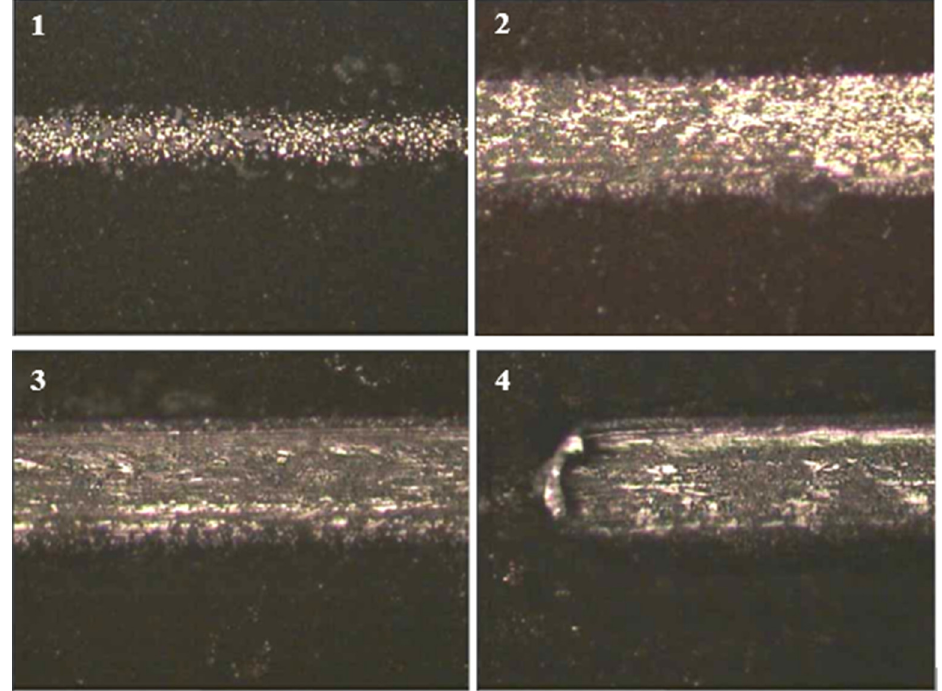
Figure 8. Micrographs of the boron coating surface under different loads exerted on a diamond indenter with a radius of 100 µm (regime 2), taken with an optical microscope; indenter loads: 1–3 indenter with a radius of 100 µ m (regime 2), taken with an optical microscope; indenter loads: 1–3 N; N; 2–6 N; 3–9 N; 4–30 N. 2–6 N; 3–9 N; 4–30